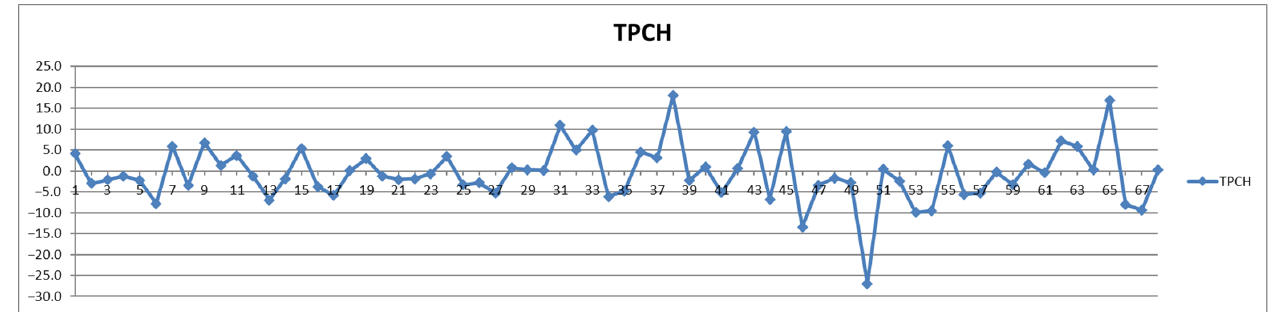
Figure 14. The food intake effect on total cholesterol (TPCH) as difference between postprandial and